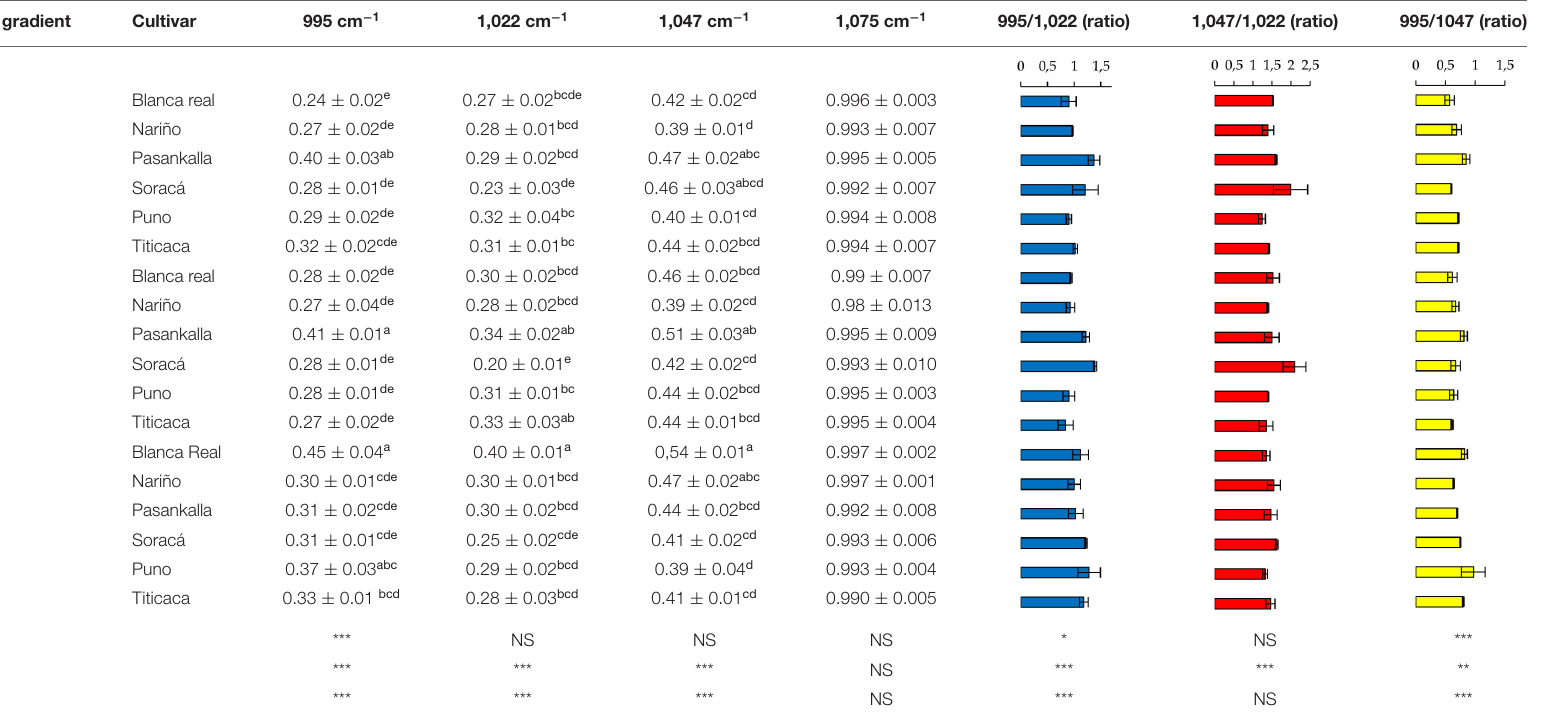
Results are expressed as the mean ± standard deviation (n = 3). Different letters indicate statistical differences, and asterisks indicate significant differences between treatments ( * p < 0.05, ** p < 0.01, and *** p < 0.001) by Tukey’s HSD test. Horizontal bars correspond to standard